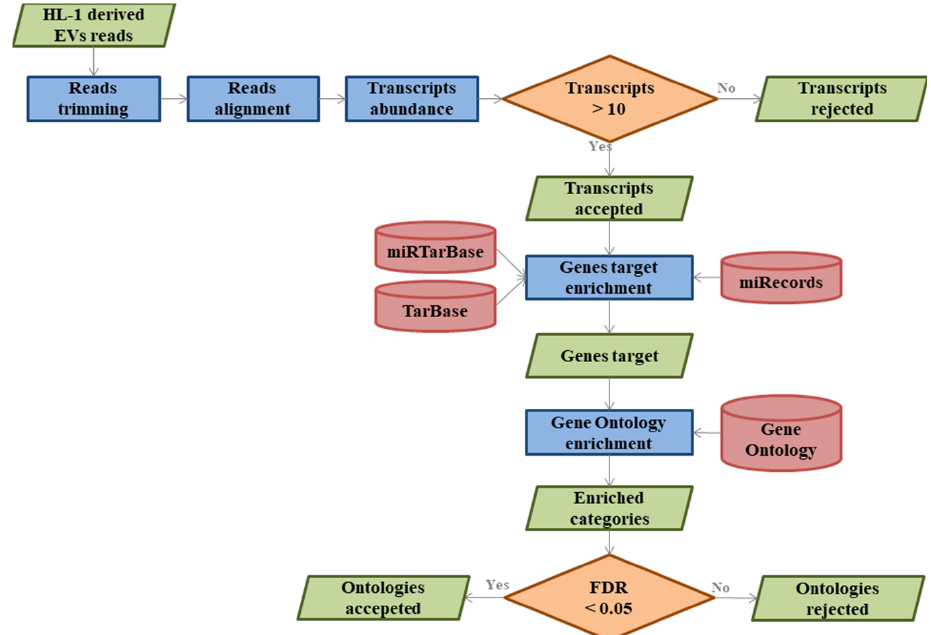
Figure 1. Flowchart of the bioinformatics analysis implemented in the study.